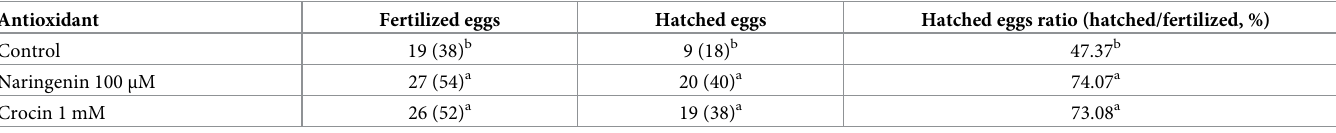
Table 6. Effect of crocin and naringenin on fertility and hatchability rates of rooster semen after freeze-thawing. Each experimental group contained 50 eggs initially. Numbers are absolute counts of eggs, with percentages (ratio respect to the initial egg count) between parentheses, except for the hatched eggs ratio.